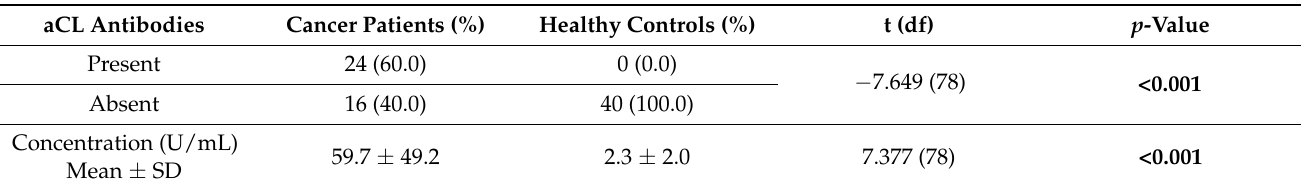
Table 2. Profile of anticardiolipin antibodies in cancer patients and healthy